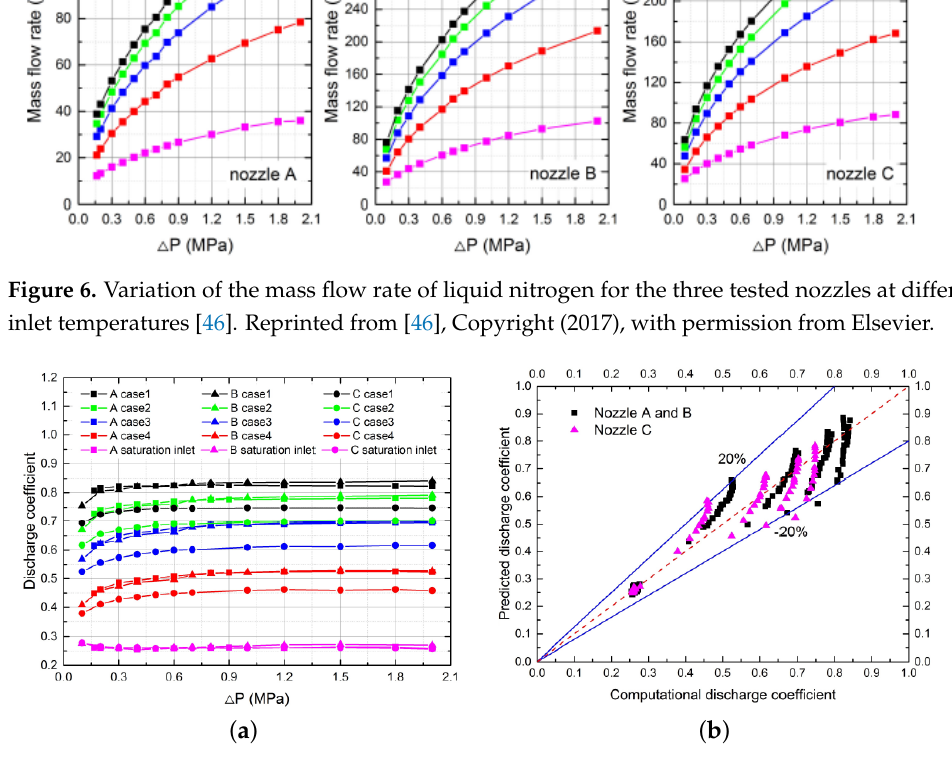
Figure 7. Discharge coefficient of the three nozzles ( a ) and comparison between computational values and predicted values ( b ) [46]. Reprinted from [46], Copyright (2017), with permission from